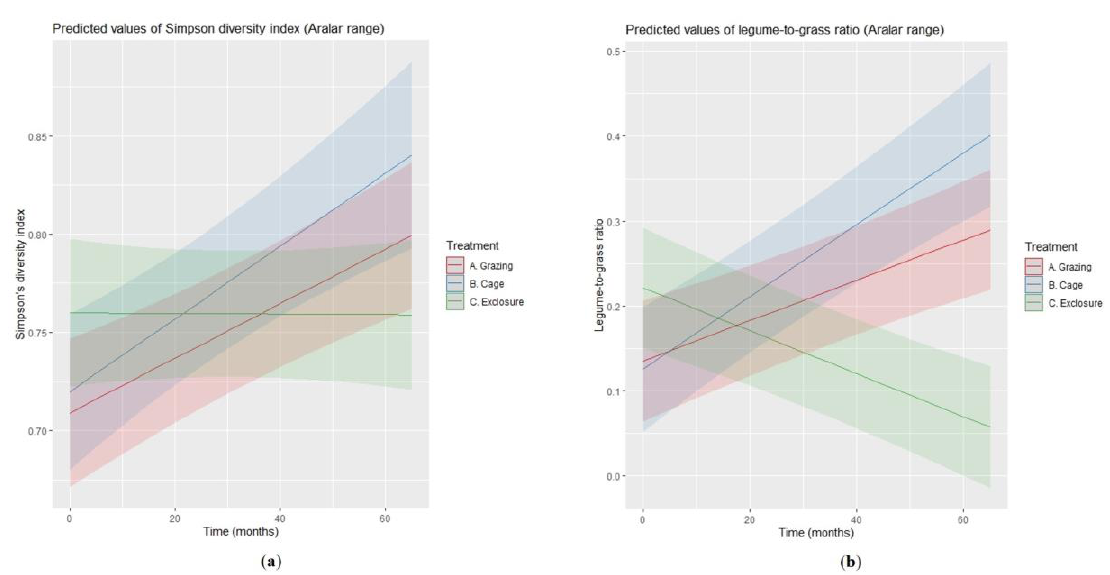
Figure 3. ( a ) Change in Simpson’s (plant) diversity index; ( b ) change in legume-to-grass ratio content. The observed patterns for the change in the proportion of dicots is similar to that for legume-to-grass ratio (see Supplementary Figure S4). Time is indexed in months, starting in June 2005 (month number 1) and ending in October 2010 (month number 65). Restricted maximum likelihood estimates (ReML) for Simpson’s index and legume-to-grass ratio at the end of each season (October) over the period 2005 – 2010 are presented in Supplementary Table S4.